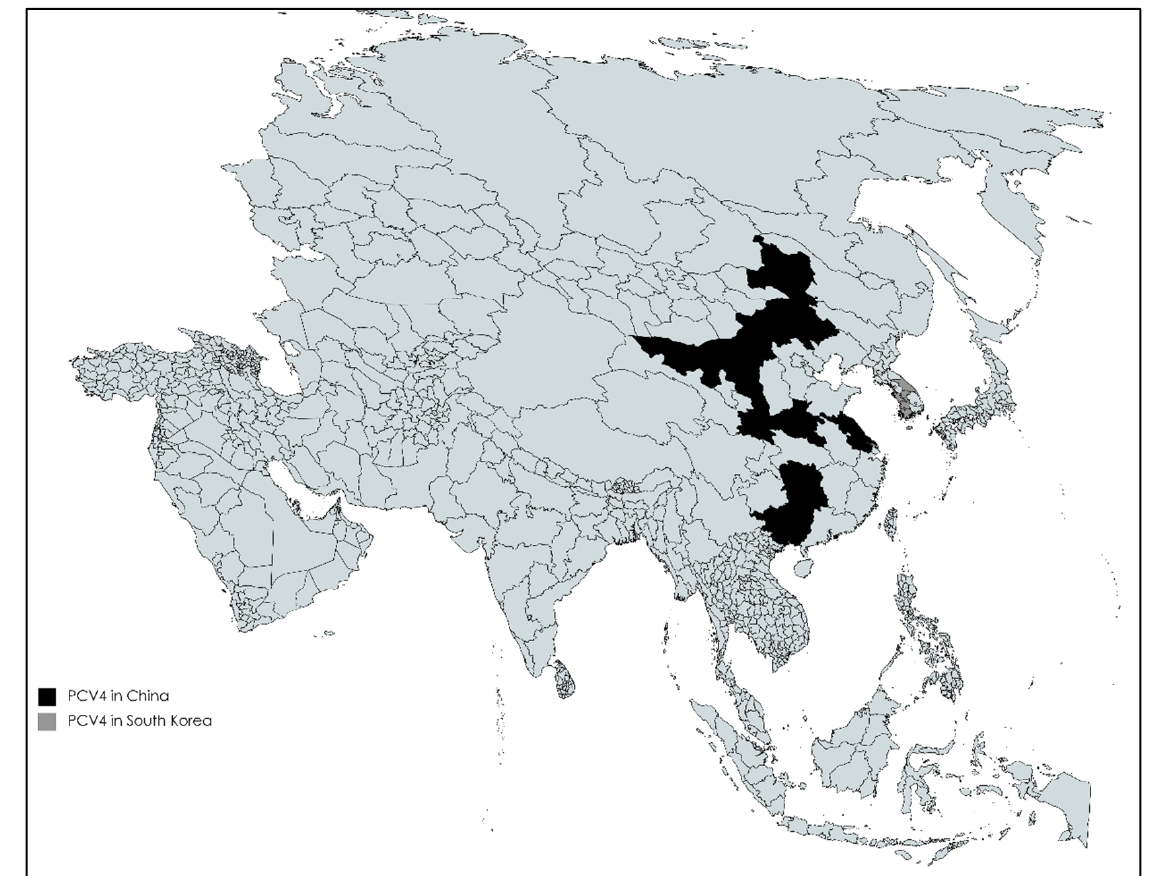
Figure 2. The occurrence of PCV4 in Asia.